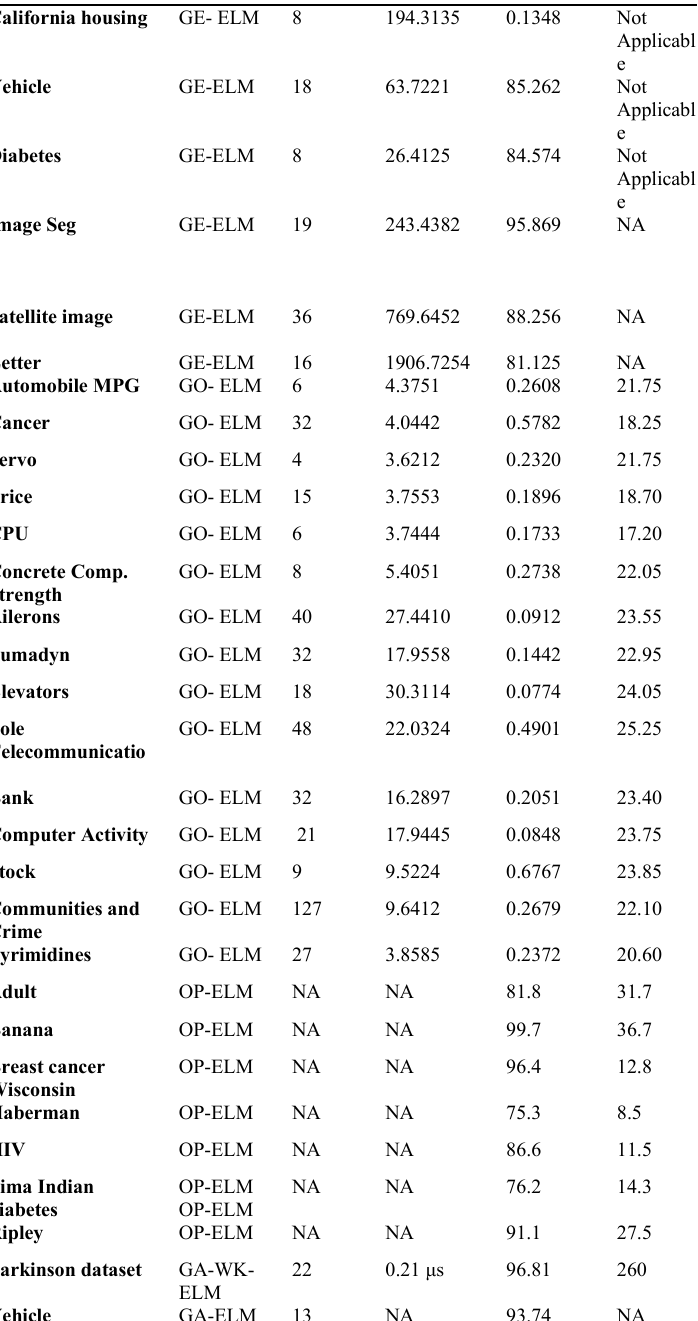
Table 1. Accuracy of the suggested algorithm according to datasets [21-28]